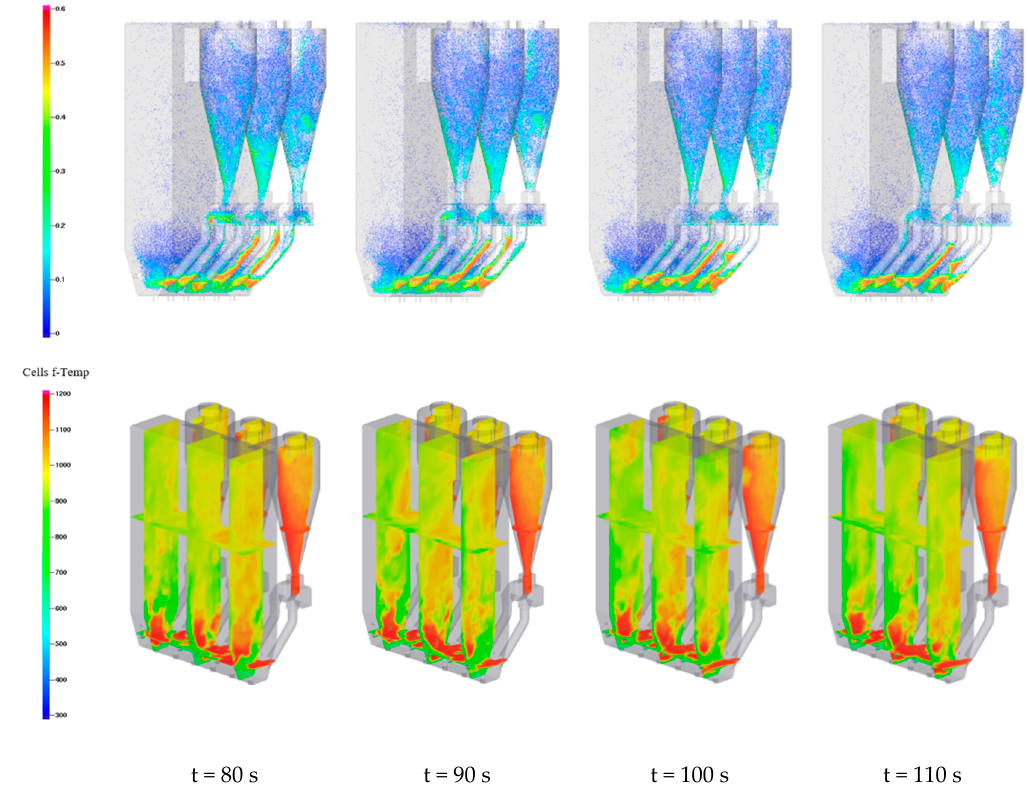
Figure 21. Distribution of flow field and temperature field during load down process (70~110 s)